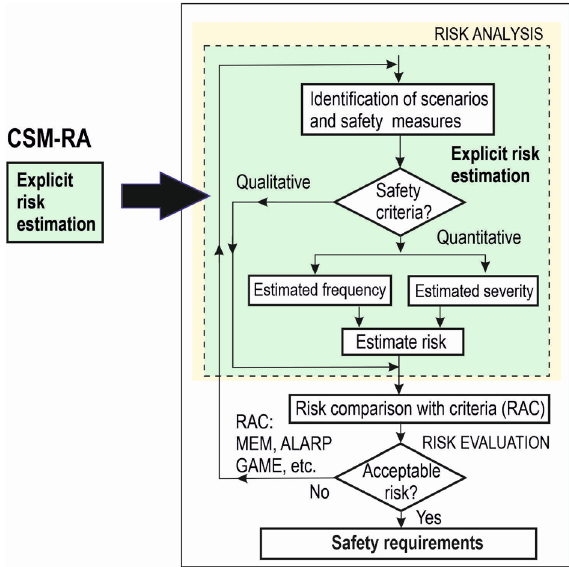
Figure 2. Flowchart of explicit risk estimation.